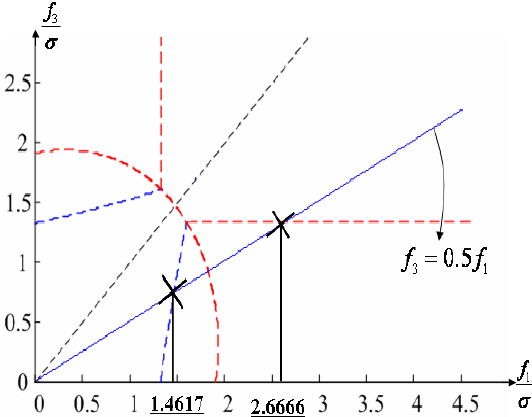
Figure 18. Accommodation rule for 1 st and 3 rd faulty sensors in Figure 13.